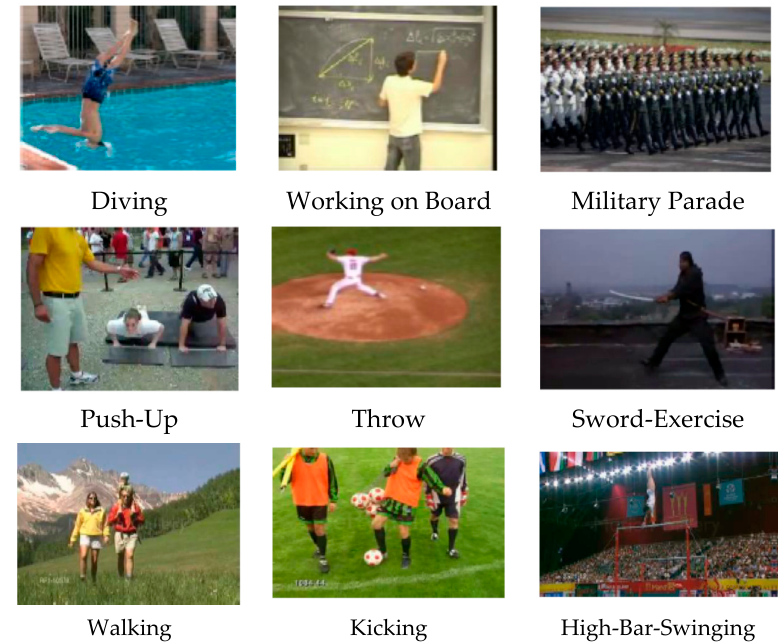
Figure 7. Sample frames from UCF101 ( first row ), HDMB51 ( second row ) and UCF Sports ( third row ).